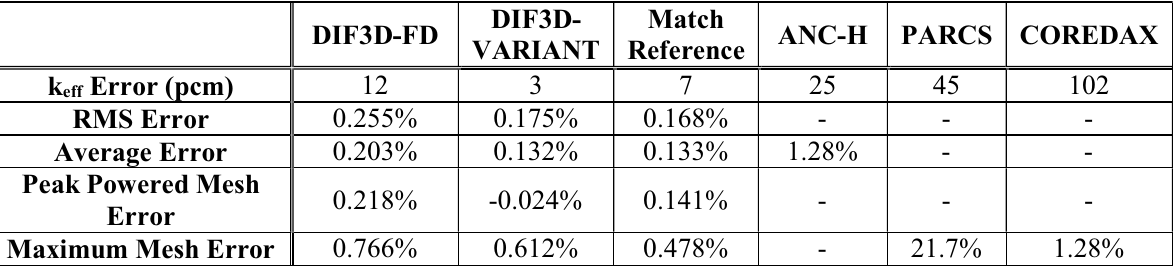
Table III. DIF3D-FD VVER-440 Power Distribution